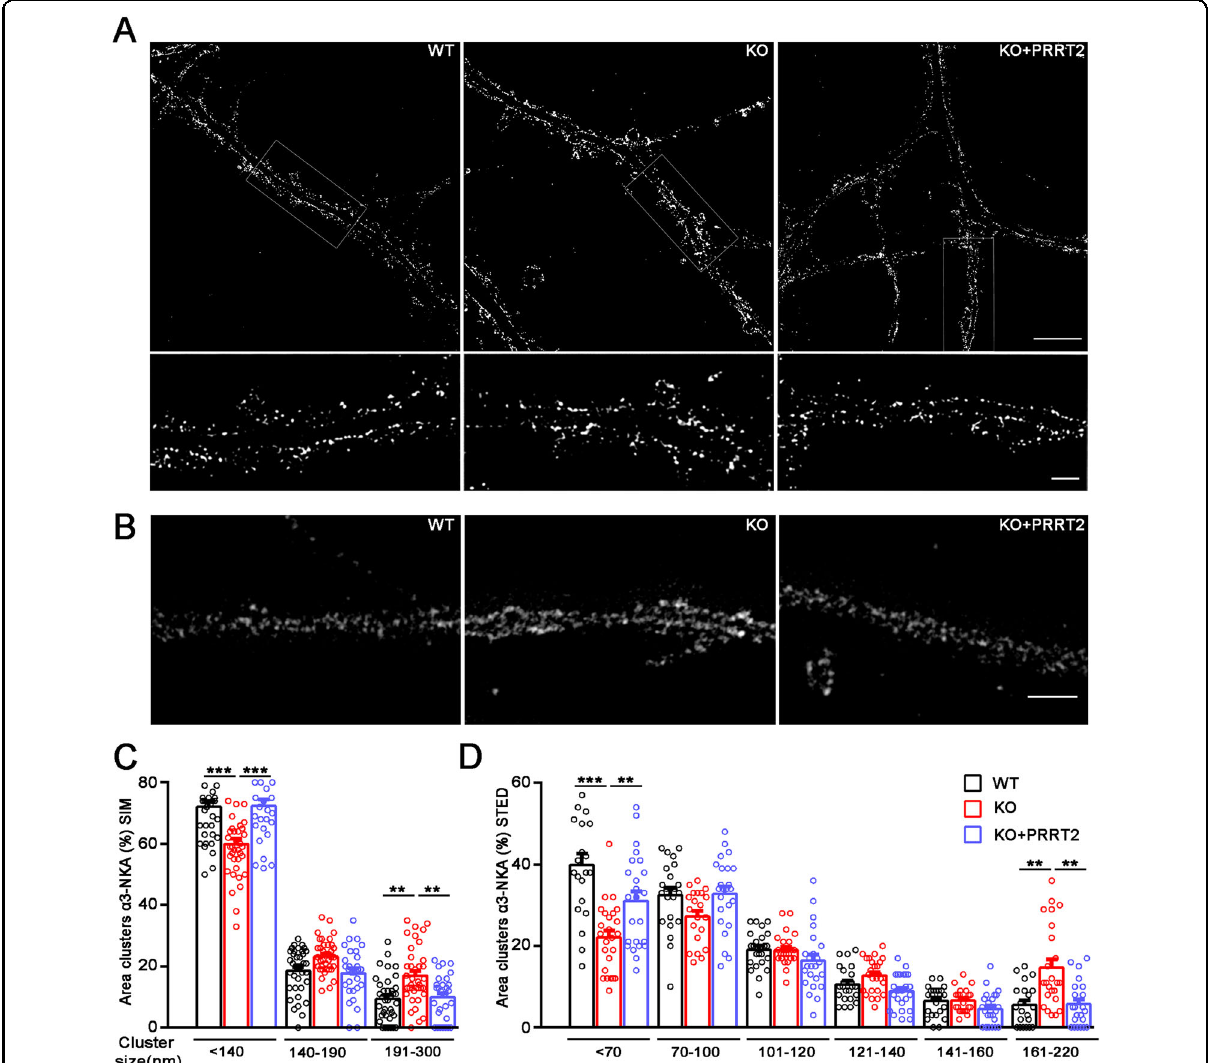
Fig. 4 PRRT2 affects α 3-NKA clustering at the membrane surface. A , B Representative 3D-SIM ( A ) and STED ( B ) images of hippocampal neurons (DIV 14-17) stained for α 3-NKA. The images highlight an altered clustering of α 3-NKA along the plasma membrane in PRRT2 KO neurons as compared to WT neurons that is rescued by expression of PRRT2 in PRRT2 KO neurons (KO + PRRT2). Scale bar, 5 μ m; insets: 1 μ m. C , D Size distribution of α 3- NKA membrane clusters. Clusters were subdivided into bins on the basis of their size as indicated. The histograms (means ± SEM) show the area occupied by each bin of α 3-NKA clusters expressed in percent of the total immunoreactive area. Both 3D-SIM ( C ) and STED ( D ) microscopy showed a signi fi cant increase in the area of largest clusters and a reciprocal decrease in the area of smallest clusters along the soma and the dendritic membrane in PRRT2 KO neurons (red bars) with respect to WT neurons (black bars). The change was fully rescued by re-expression of PRRT2 in PRRT2 KO neurons (KO + PRRT2, blue bars). Data refer to n = 35 (3D-SIM) and 25 (STED) neurons per genotype, from n = 3 independent preparations (3 coverslips/preparation/genotype). ** p < 0.01, *** p < 0.001; one-way ANOVA/Bonferroni